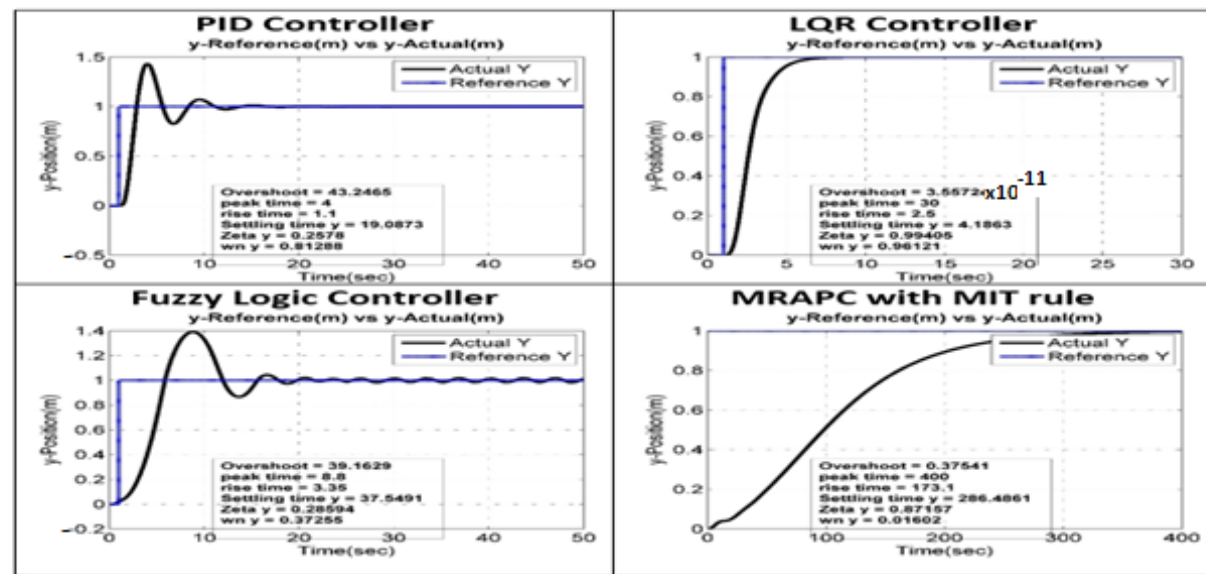
Figure 14. Step response result of all control systems along the y − axis